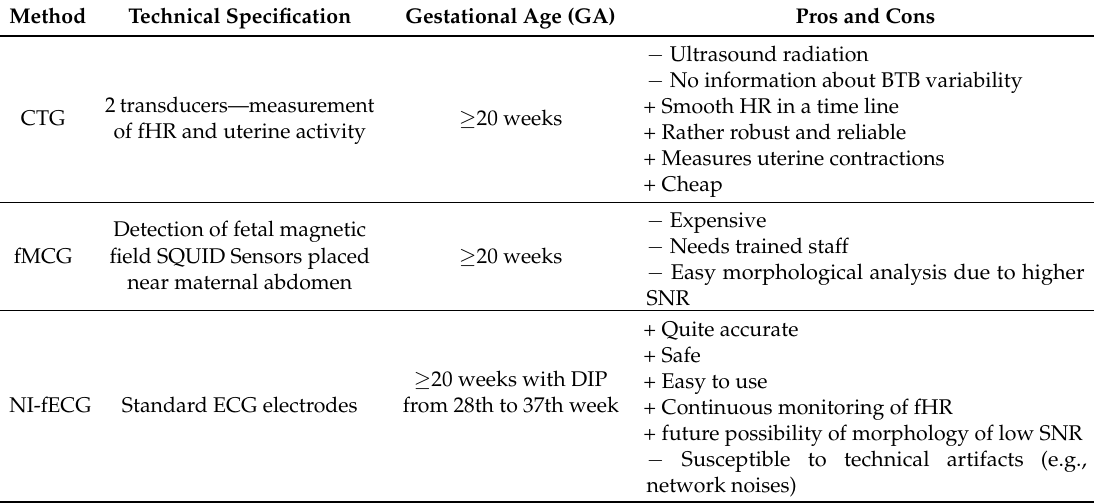
Table 1. Summary of main methods used for the noninvasive electronic fetal heart rate